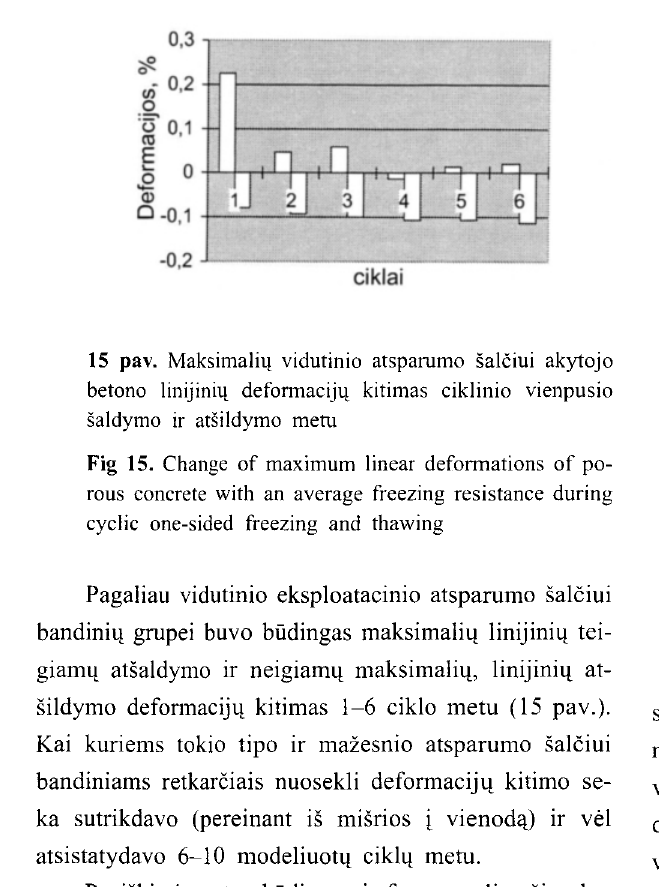
Fig 15. Change of maximum linear deformations of po rous concrete with an average freezing resistance during cyclic one-sided freezing and thawing Pagaliau vidutinio eksploatacinio atsparumo salCiui bandinil! grupei buvo budingas maksimalil! linijinil! tei giaml! atSaldymo ir neigiaml! maksimalil!, linijinil! at sildymo defonnacijl! kitimas 1-6 ciklo metu (15 pav.).